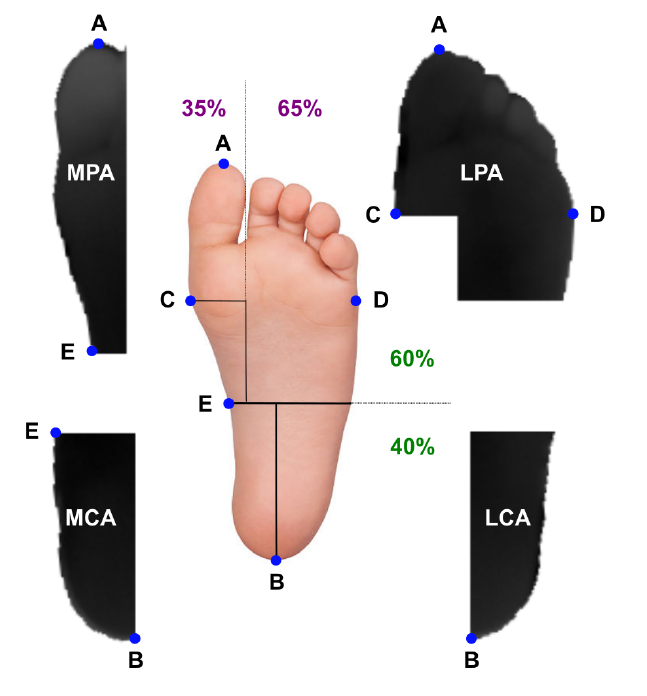
Figure 2. Graphical illustration of the defined angiosomes. The main reference points considered and the proportional foot division are also specified [41,47]. Reference point A was located at the tip of the innermost toe, whereas B at the center of the calcaneal base. Points C and D corresponded to the wider part of the foot. Point E corresponded to the 60% height of the